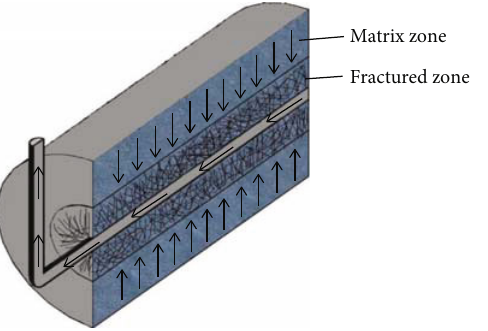
Figure 2: Division of fl ow fi eld around fractured horizontal well in tight oil.